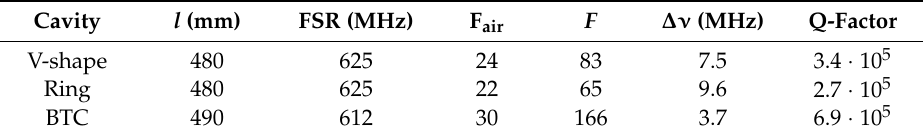
Table 1. Main paramen comparison with the ones for the V-shapedters calculated for the bow-tie cavity, i and ring cavities [20] (FSR: Free spectral range). All parameters are calculated in vacuum, apart from column F air reporting the finesse values taking into account the water vapor absorption coefficient of ~0.0038 cm − 1